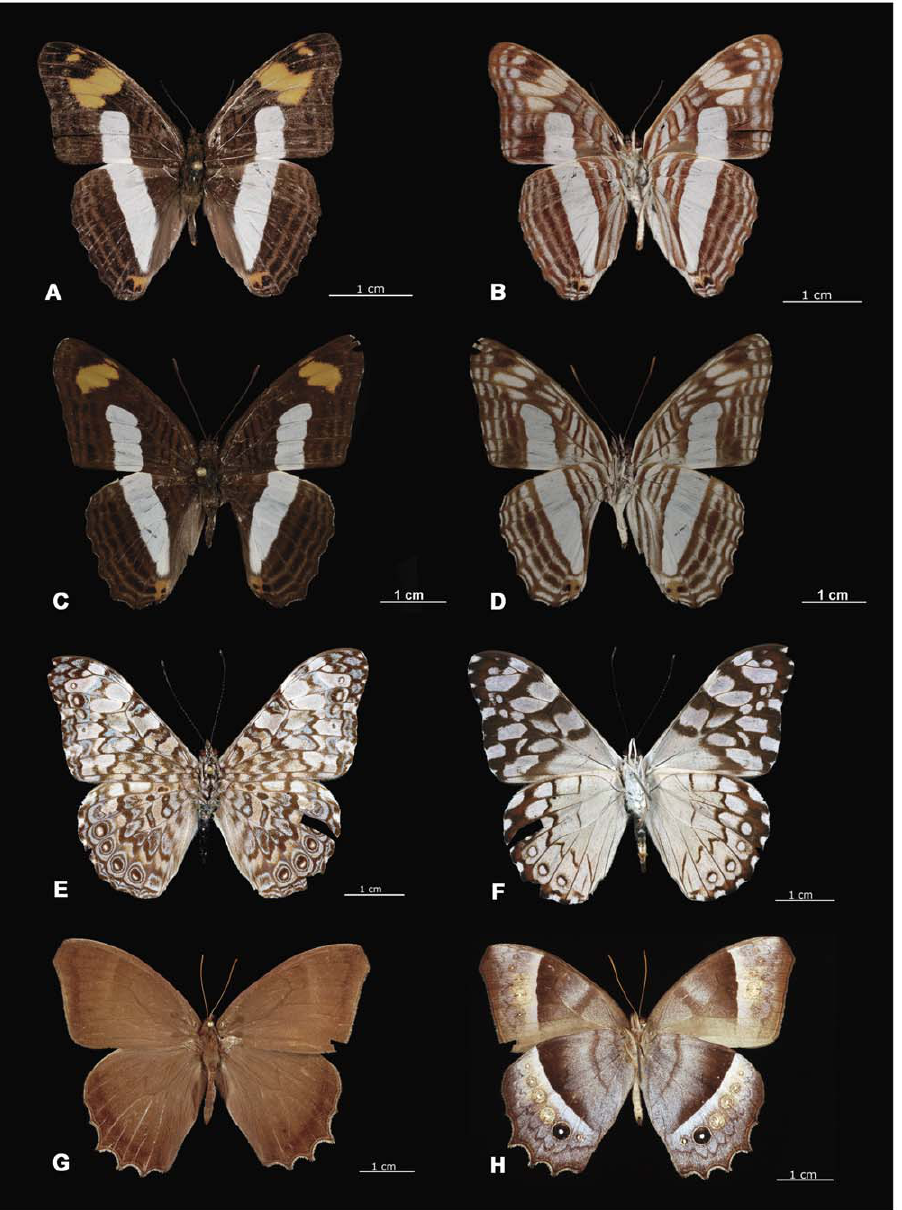
Figure 1. Four overlooked Nymphalidae species within the Lepidoptera collection of ECOSUR from the Yucatan Peninsula. A–B) Adelpha malea ; C–D) Adelpha iphiclus ; E–F) Hamadryas iphtime ; G–H) Taygetis laches . Each species is shown in dorsal and ventral view. A. iphiclus is a new record for the Yucatan Peninsula while T. laches is a new record for Mexico. Photos by Humberto Bahena.